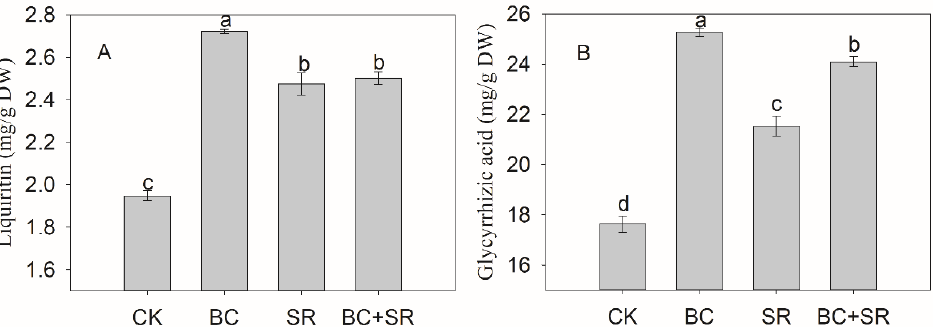
Figure 2. Effect of different soil types on liquiritin ( A ) and glycyrrhizic acid ( B ). CK, sand only; BC, biochar; SR, sand and soft rock; BC + SR, sand, biochar, and soft rock. Data are shown in mean ± SD. Different letters indicate significant differences ( p < 0.05).